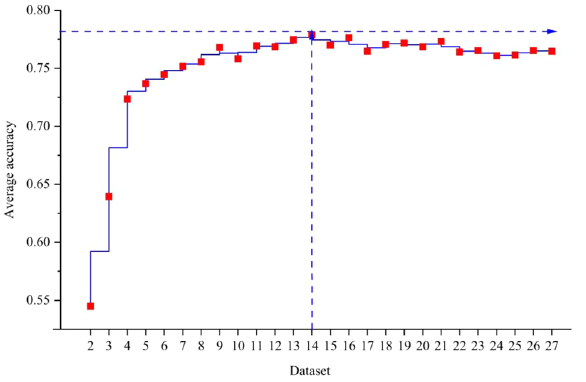
Figure 7. Average prediction accuracy of 26